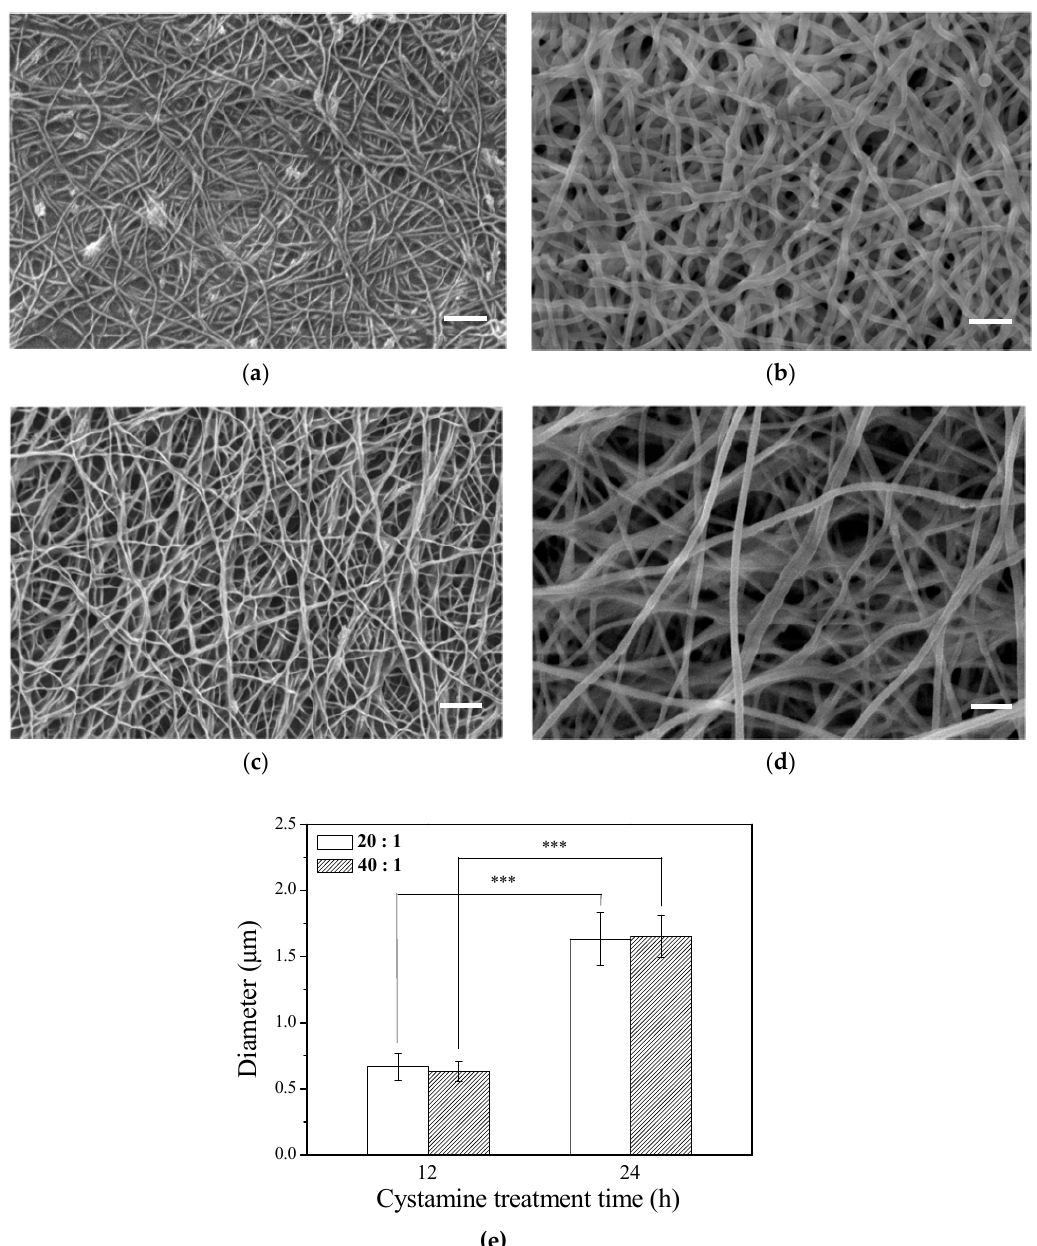
Figure 1. SEM images of the γ –PGA/ β –TCP composite fibrous mats with different γ –PGA/ β –TCP weight ratios and different cystamine treatment times: ( a ) 20:1, 12 h; ( b ) 20:1, 24 h; ( c ) 40:1, 12 h; and ( d ) 40:1, 24 h. ( e ) The diameter of the electrospun γ –PGA/ β –TCP composite fibers (*** p < 0.005). Scale bars: 2 µm.